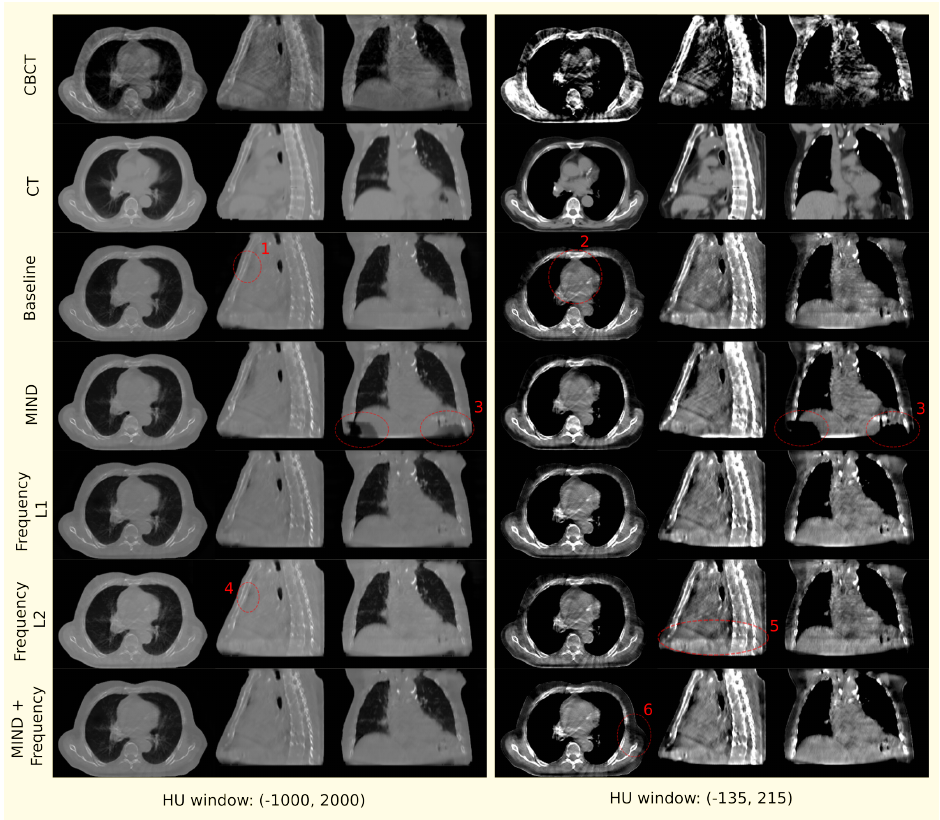
Figure 4. Mid − axial, sagittal, and coronal views for CBCT, CT, and generated images from models with different data-driven constraints for a patient chosen randomly from the test set. Qualitative observations discussed in the text are numbered and marked with red dotted ellipses.